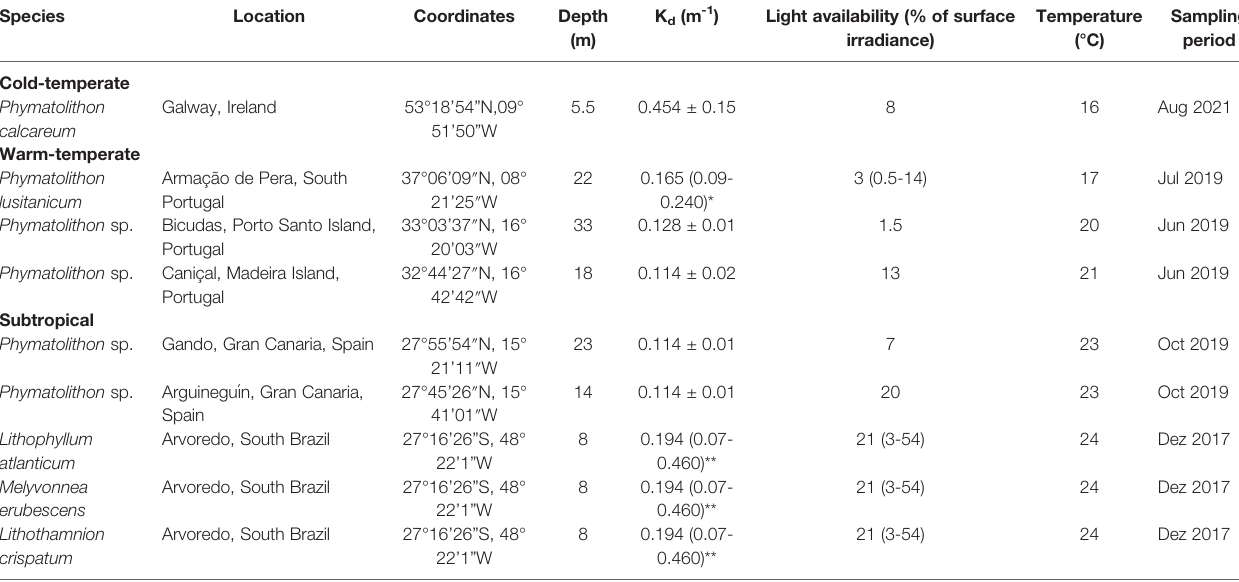
TableLegend:DataforK d represent mean±SD(n=5-6). Somelocationsexperience strong fl uctuationsinK d (min-max)dueto(*)fast inversionsbetween up-anddownwellingconditions (see Schubert et al., 2021b) and (**) in fl uence of wind-driven currents (summer K d values from MAArE (2017).